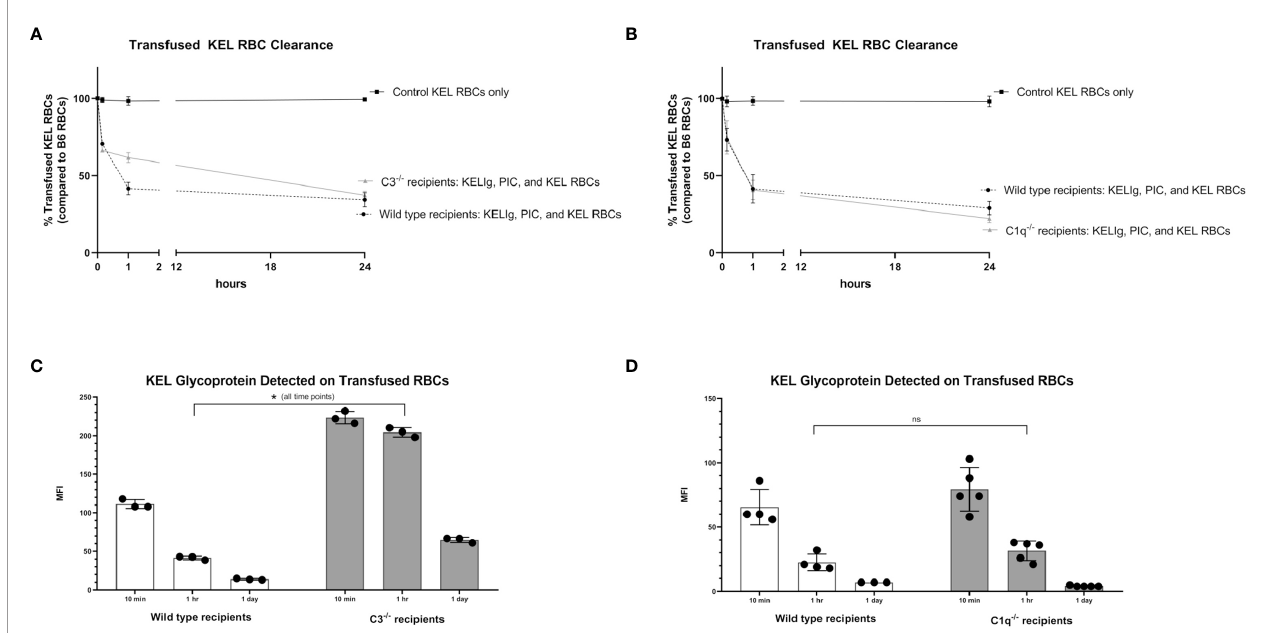
FIGURE 3 | Recipient complement, KEL RBC clearance, and KEL antigen expression. KEL RBCs were labeled with DiO and mixed with wild type RBCs labeled with DiI; this mixture was transfused into recipients that had been infused with KELIg and treated with poly (I:C). (A) shows wild type compared with C3 -/- recipients; (B) shows wild type compared with C1q -/- recipients. Recovered DiO labeled RBCs were then evaluated for KEL glycoprotein expression by fl ow cytometry, after incubation with KELIg and fl uorescently conjugated anti-mouse IgG; (C) shows wild type recipients compared with C3 -/- recipients; (D) shows wild type recipients compared with C1q -/- recipients. These data are representative of 2-3 independent experiments with 3 mice/group/experiment; error bars indicate standard deviation between mice. *p < 0.05 for all comparisons in (C) and p = ns, not signi fi cant for all comparisons in (D)